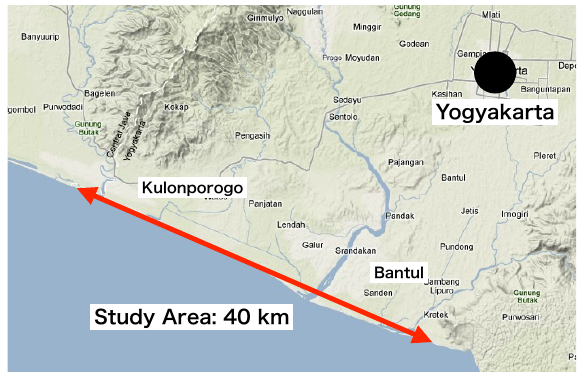
Fig. 3. Typical ground topography of the study area